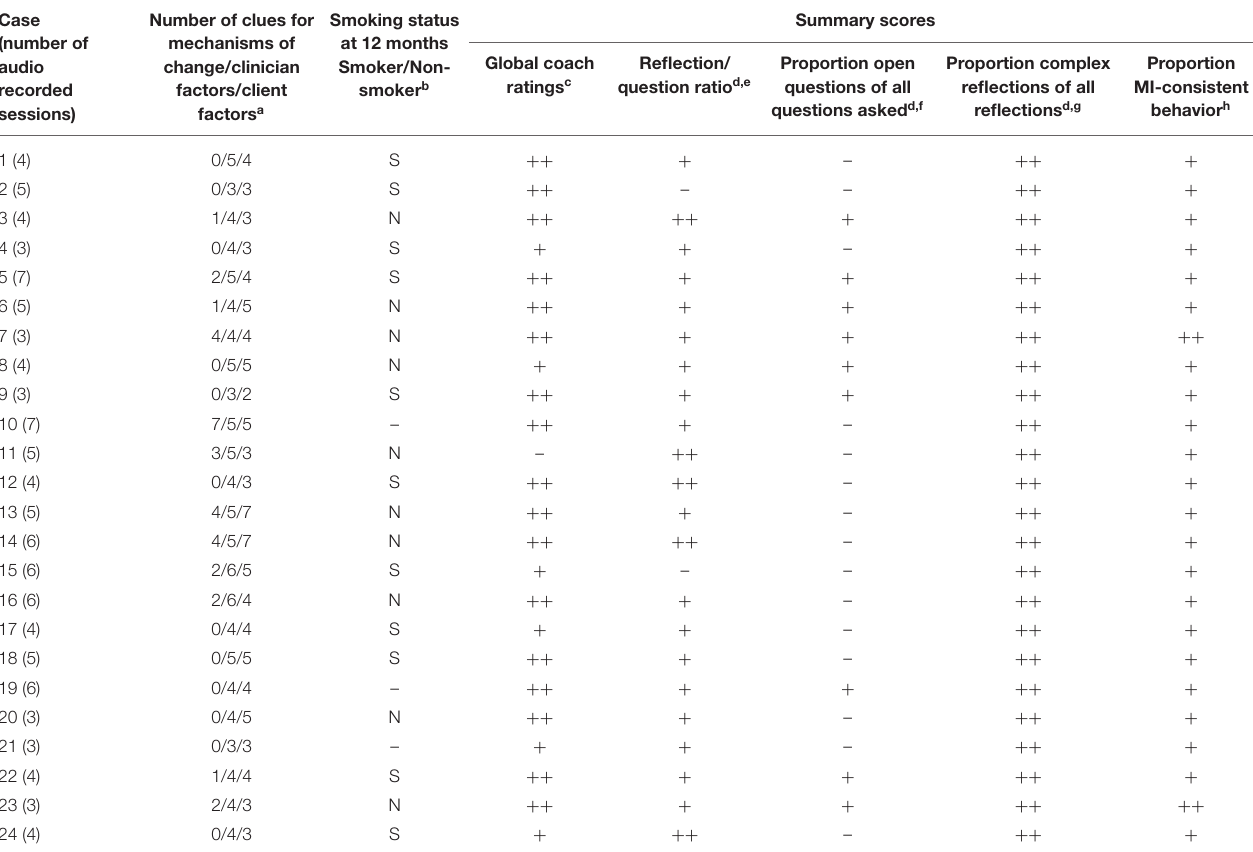
TABLE 10 | Number of observed clues for mechanisms of change, clinician and client factors, smoking status, and summary scores per case. Case (number of audio recorded